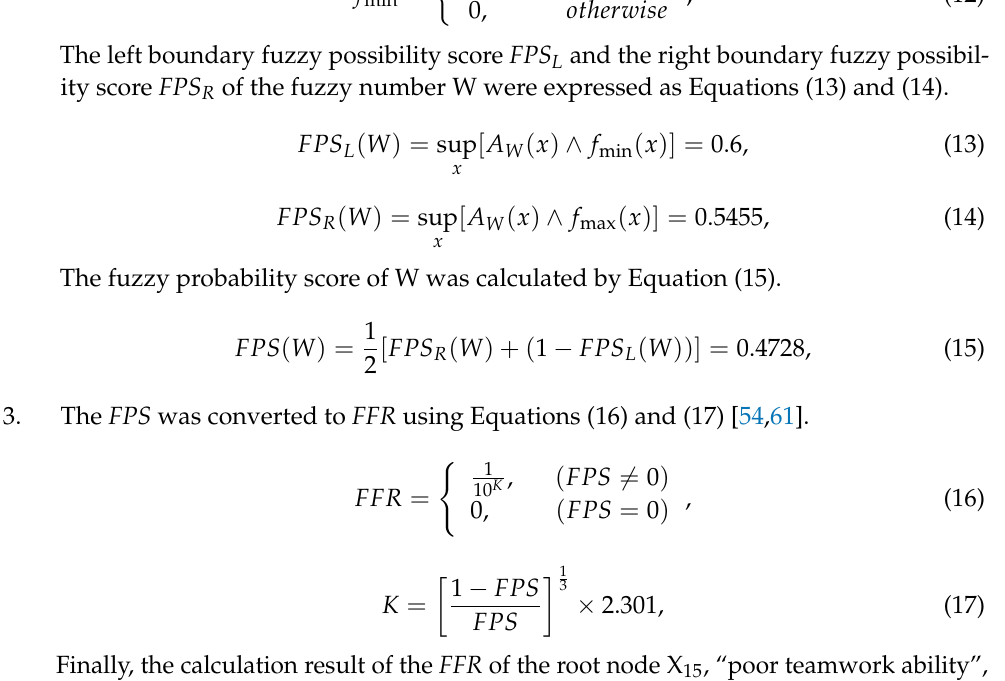
Table 4. To simplify the analysis, the two states of the root node were defined as “Yes” or “No” according to the characteristic of the root